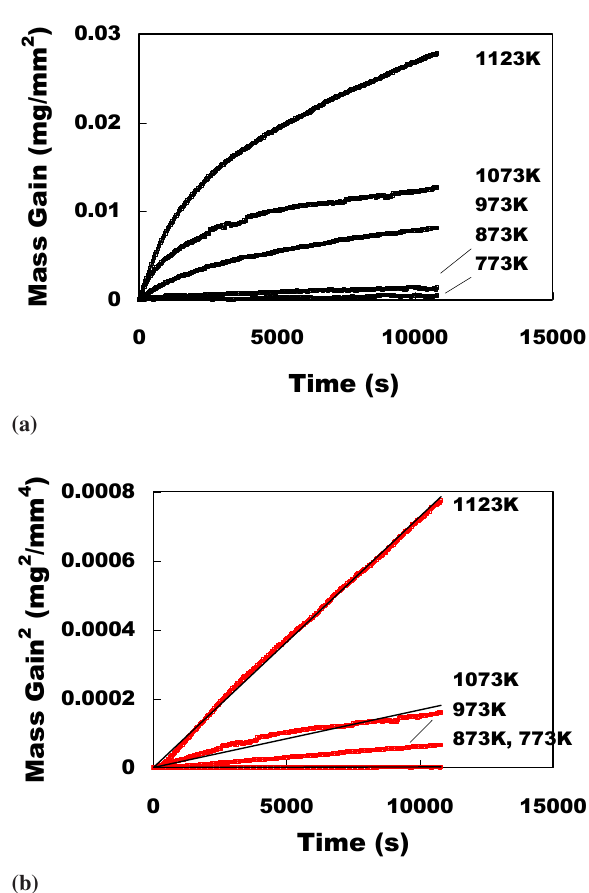
Figure 1. Oxidation kinetics of Cu-38at.%Zn specimens af- ter oxidation at 773–1123 K (a) mass gain versus oxidation / 2 versus time time and (b) . (cid:2)W A